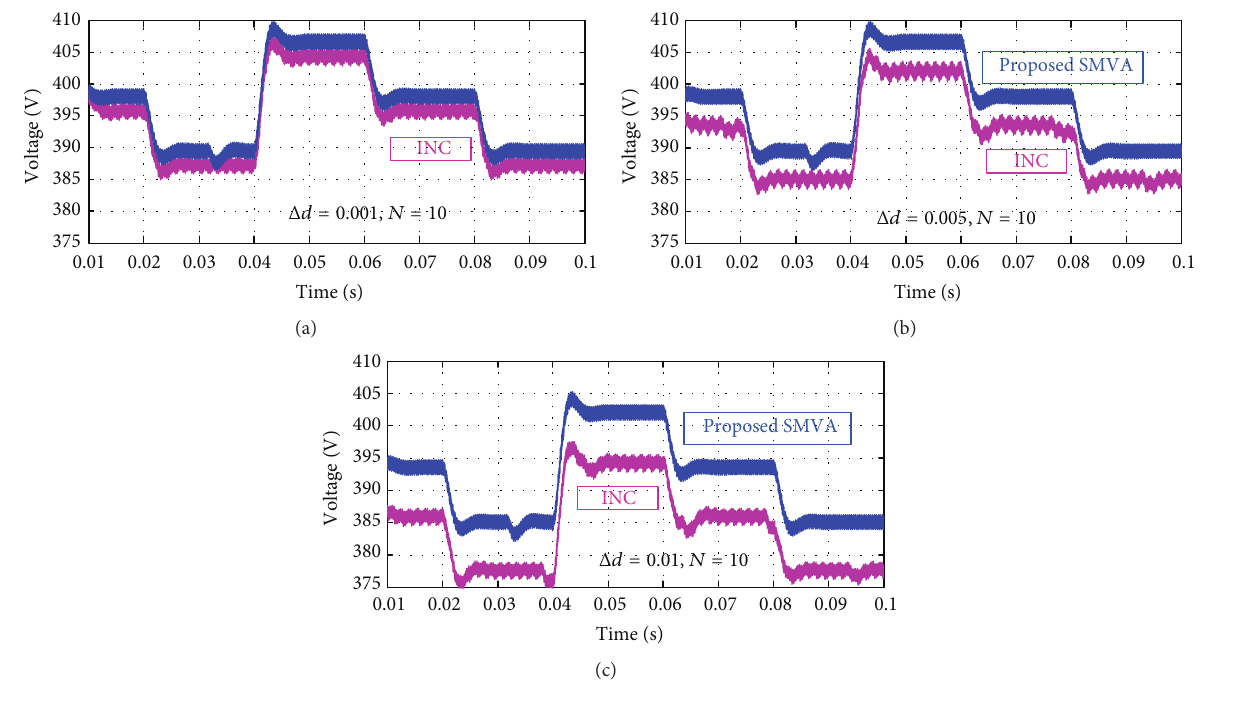
Figure 12: Output voltage comparison with Δ𝑑 = 0.001 , 0.005, and 0.01 and 𝑁 = 10 .